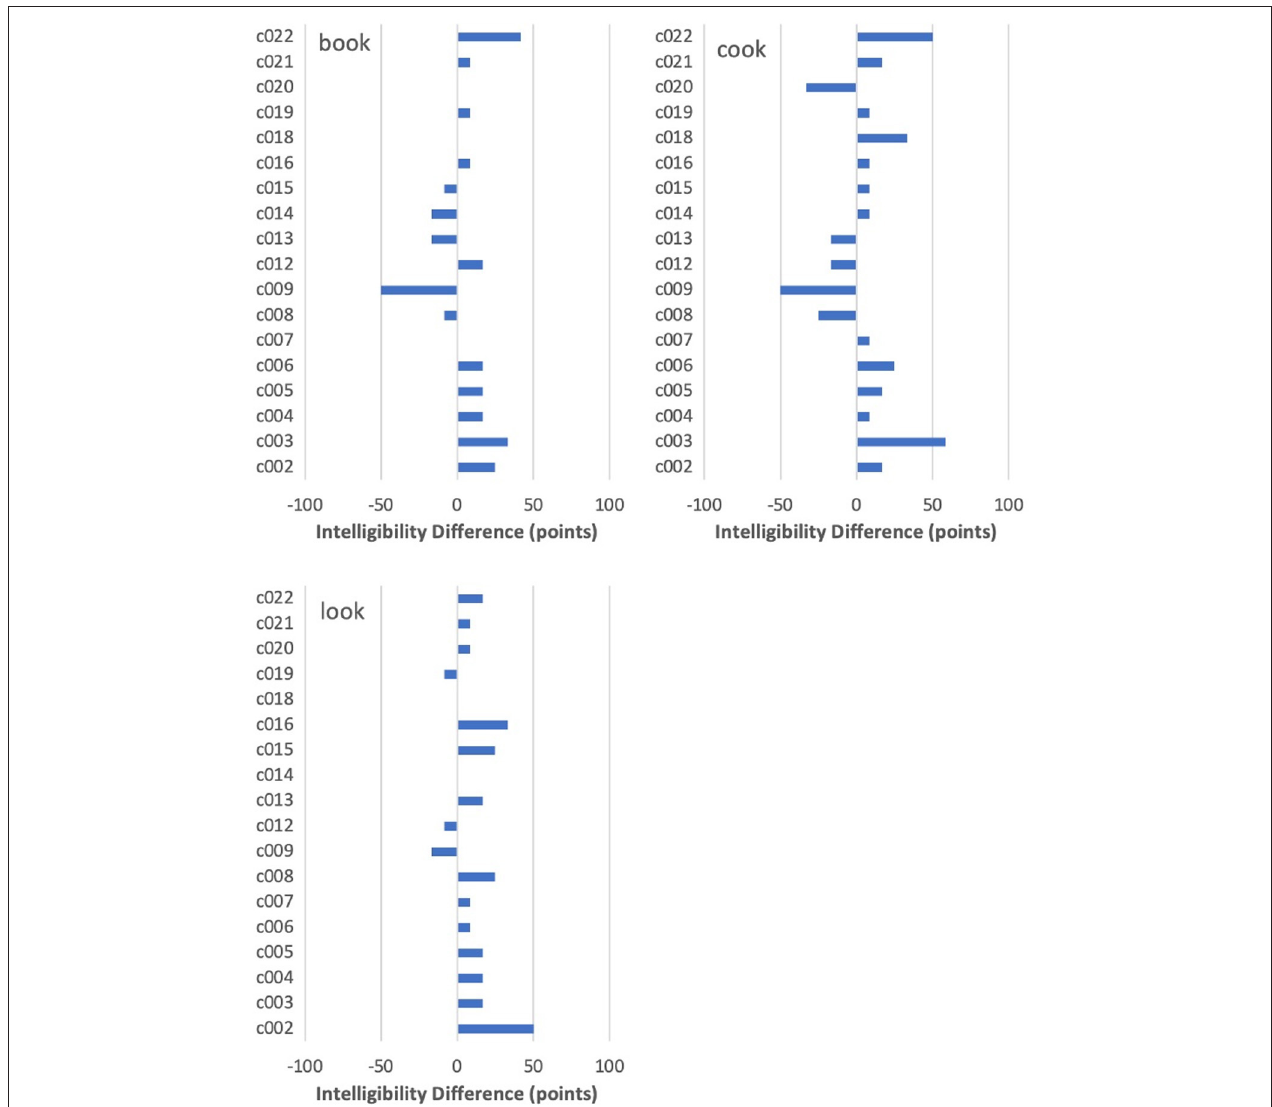
FIGURE 5 | By-speaker differences between mean intelligibility scores on the two tasks for book, cook, and look